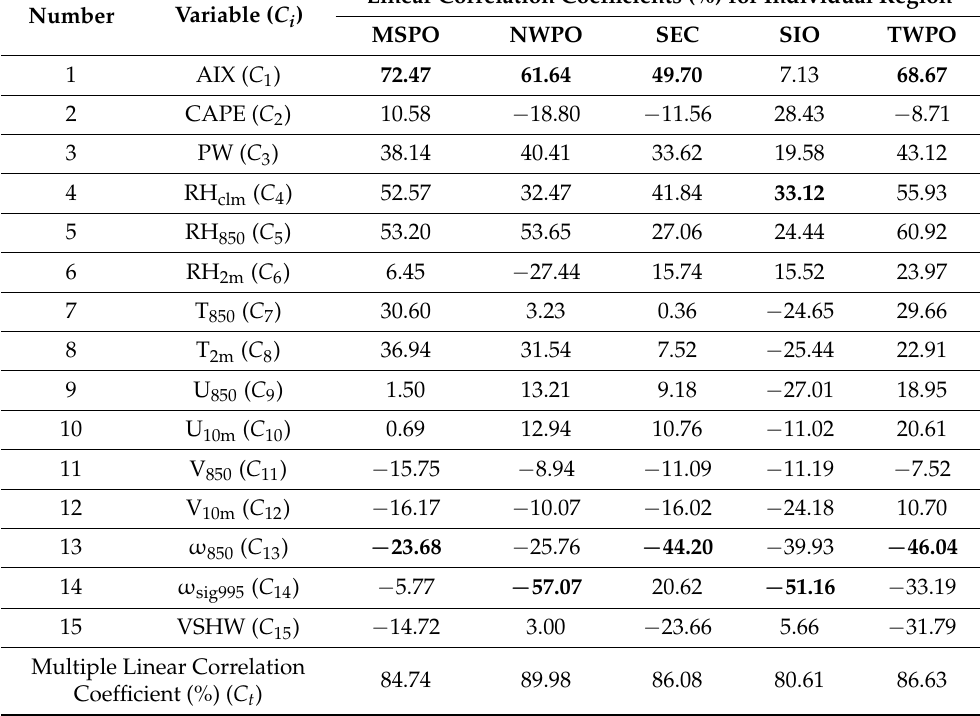
Table 2. The individual correlation coefficients ( Ci, i = 1, 2, . . . , 15) from the MVLR analysis for the cloud microphysical variable CPER in the five regions of Table 1. The correlation coefficients are normalized to 100 and expressed in the unit of percentage (%). The highest negative and positive correlation coefficients among the fifteen individual correlation coefficients for AIX and the fourteen meteorological variables are highlighted in bold font for each region. The multiple linear correlation coefficient ( Ct ) represents the total correlation of CPER with AIX and the fourteen meteorological variables. Linear Correlation Coefficients (%) for Individual Region Number Variable ( C i ) MSPO